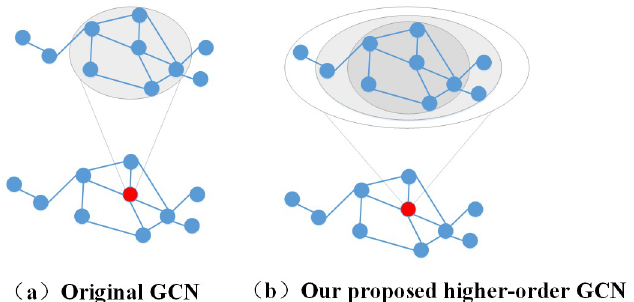
Fig 1. Message passing procedure in original GCNs (a) compared to ours (b). The original GCN follows a 1-hop neighborhood aggregation scheme, which considers only the immediate neighbor information for each node. Our proposed model explores and propagates graph topological information across the highly-order neighborhood of each node in every convolutional layer.